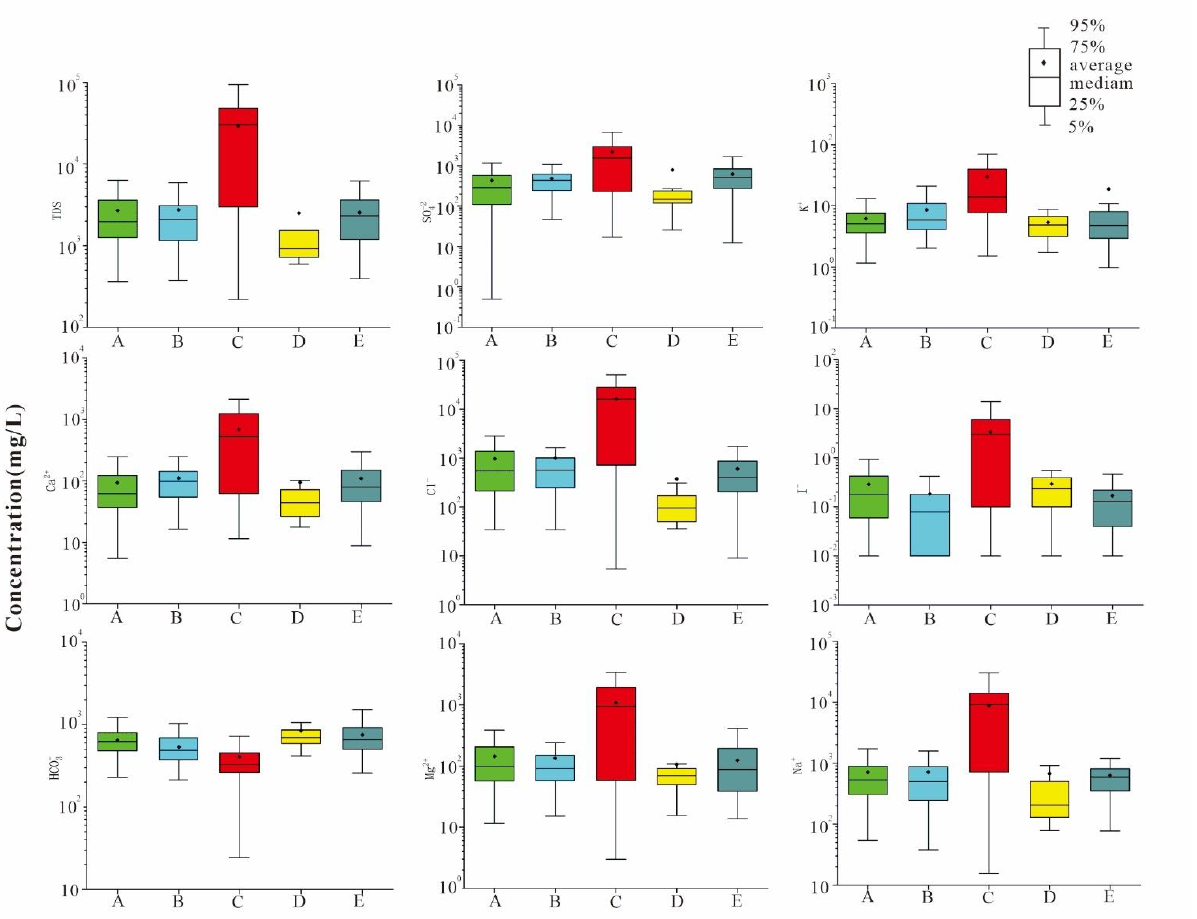
Figure 4. Box plot of TDS and the main ion concentrations in the five zones according to the map in Figure 3. Table 1. Correlation between main chemical components of groundwater and TDS in highly min- eralized water distribution zone.